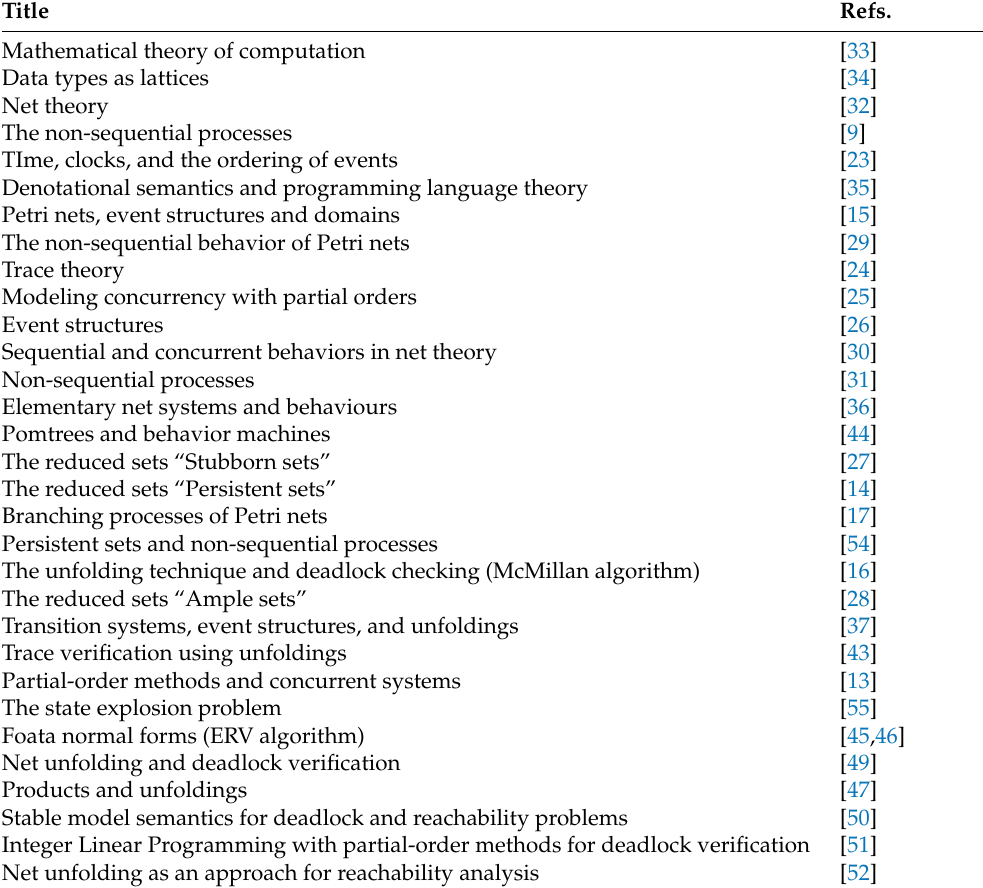
Table 1. Reported work on the earliest motivations to the foundation of the unfolding in discrete event